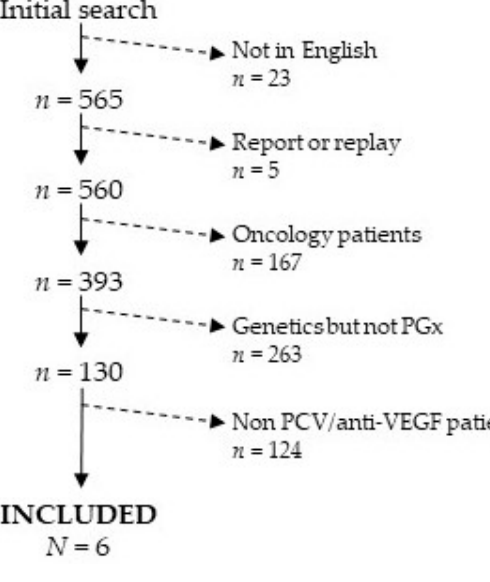
Figure 1. Bibliography search strategy.